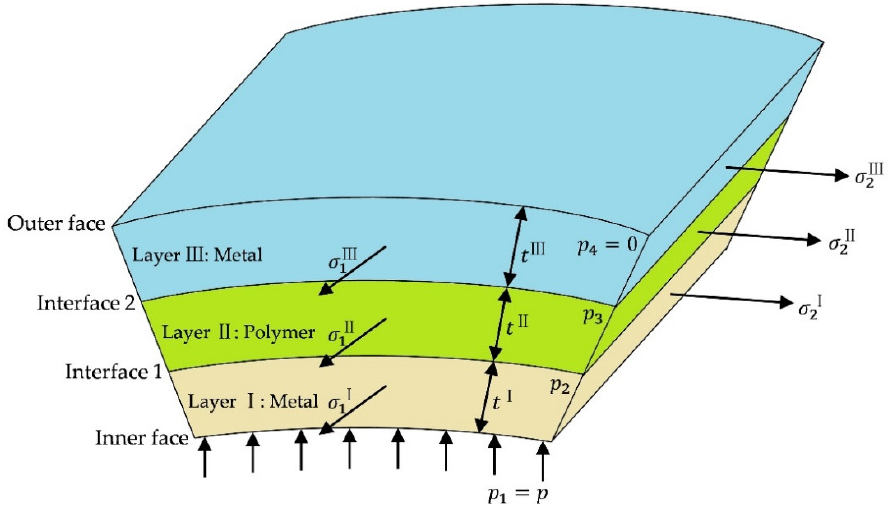
Figure 2. Structure of the three-layered sandwich panel.